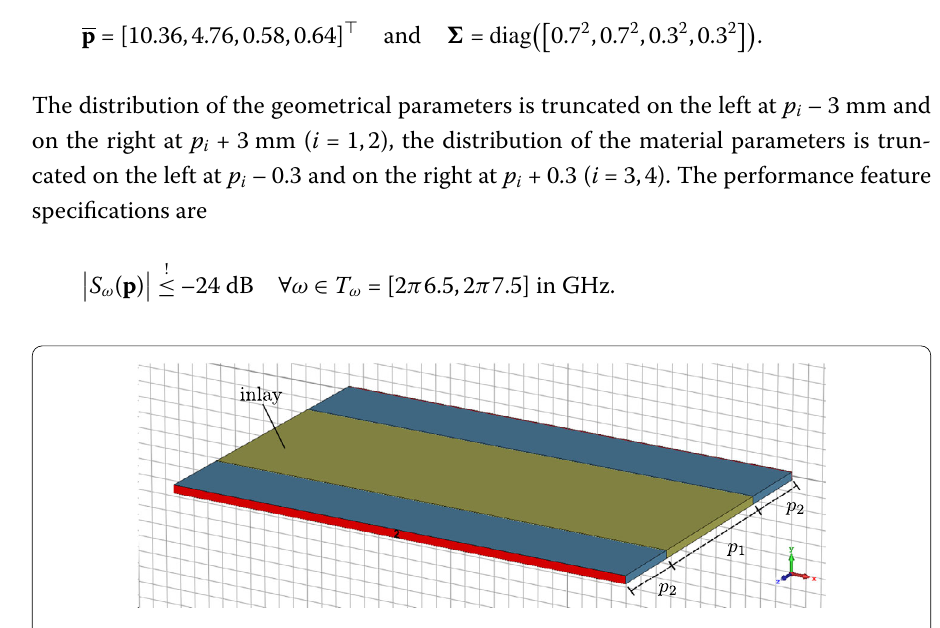
Figure 1 Rectangular waveguide with dielectrical inlay of length p 1 modelled in CST